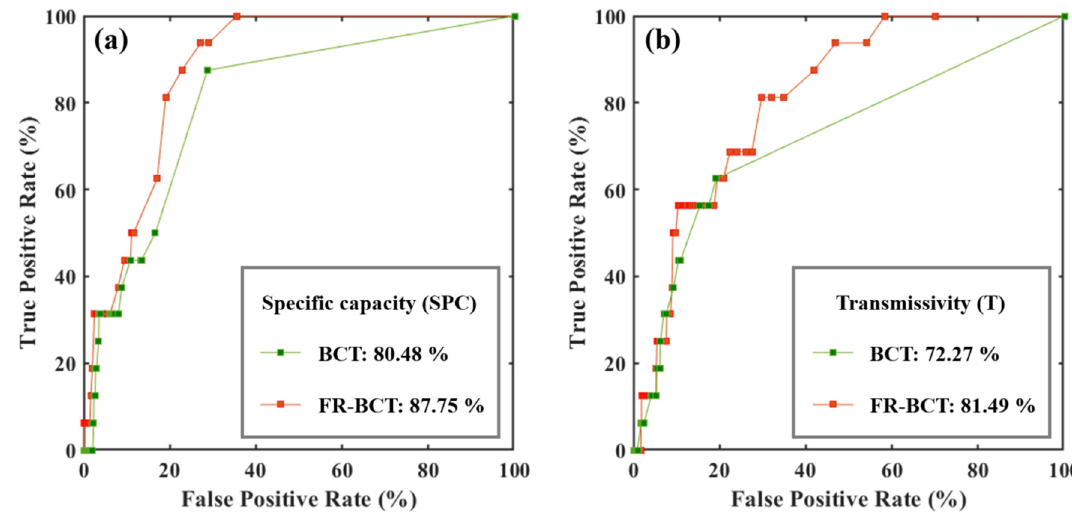
Figure 7. Testing results of the BCT and FR-BCT models for ( a ) SPC and ( b ) T groundwater data.